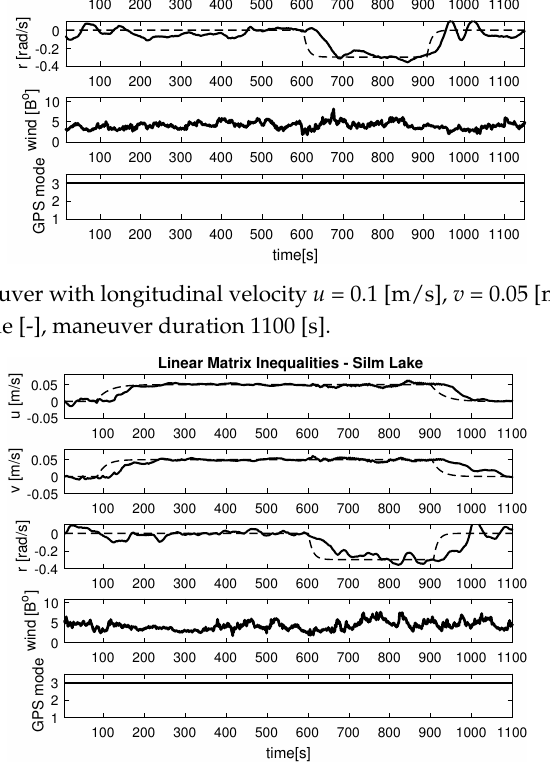
Figure 16. Ahead maneuver with longitudinal velocity u = 0.05 [m/s], v = 0.05 [m/s], r = − 0.3 [rad/s], wind [ B o ] and GPS mode [-], maneuver duration 1100